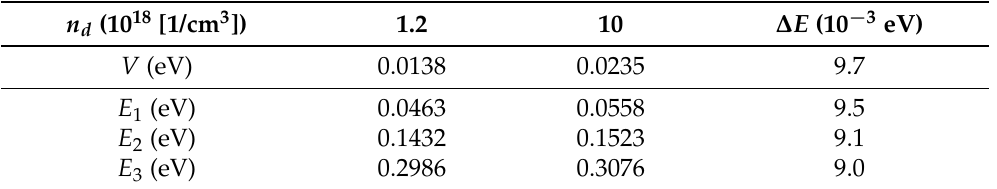
Table 2. Energy associated with the conductance peaks and potential at the center of the well and their differences ∆ E for the two calculated concentrations, the data correspond to Figure 9.